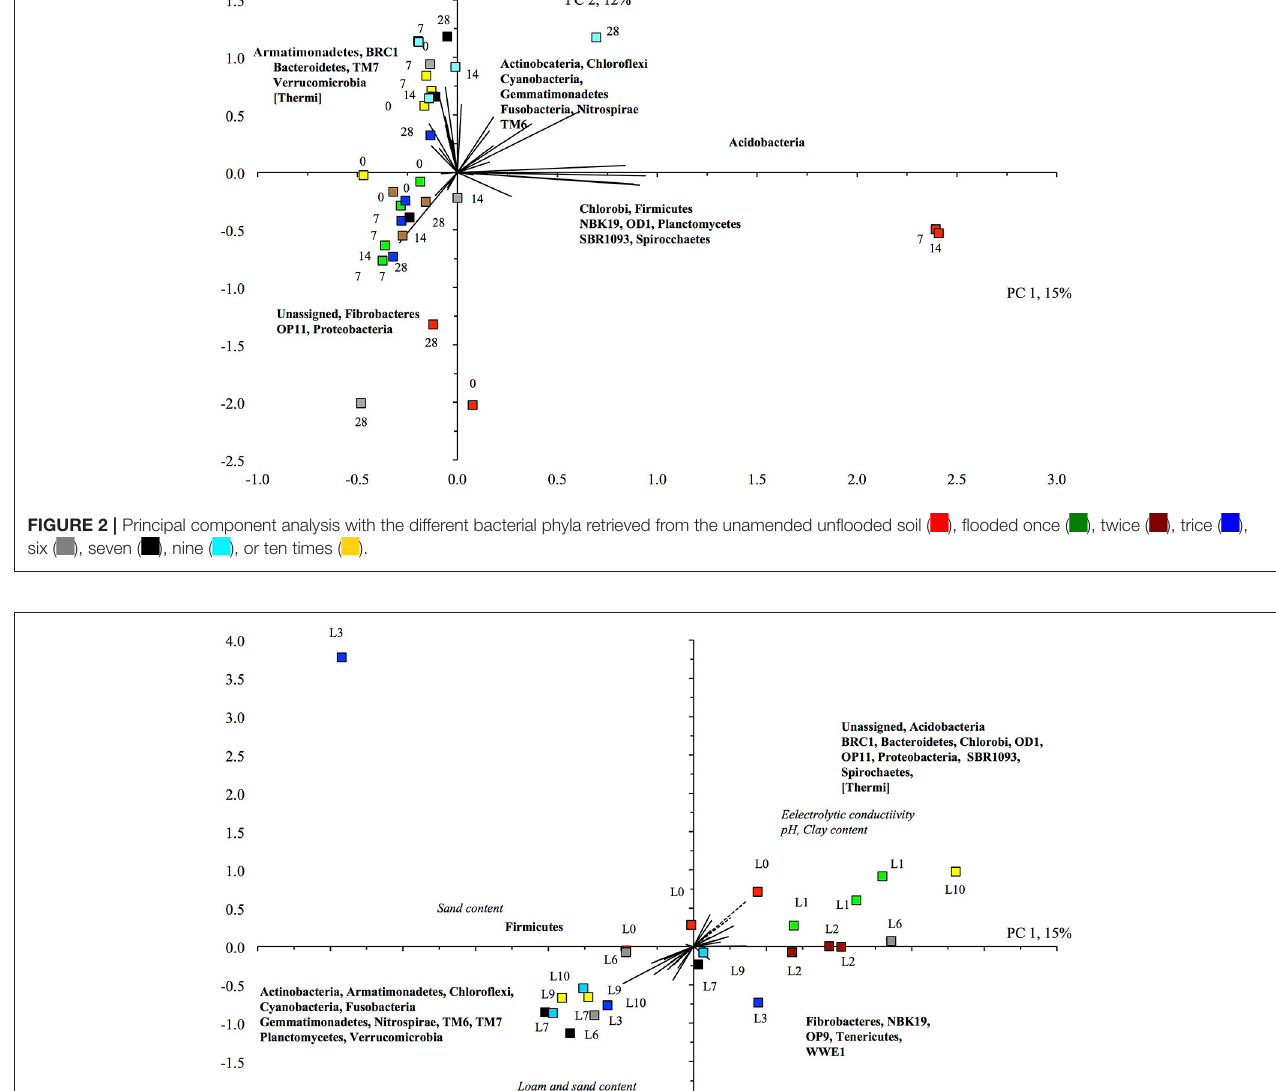
10 times amended with organic material (Figures S4,